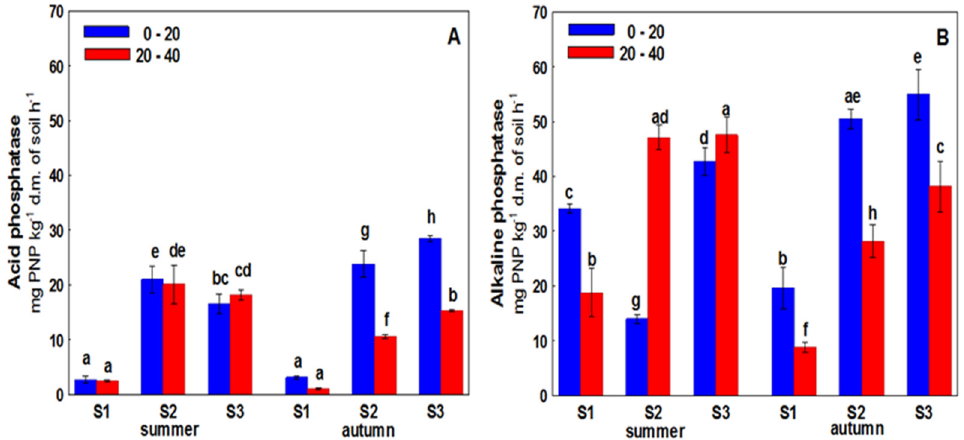
Figure 3. Enzymatic actvity in soil from 0–20 and 20–40 cm depths: ( A ) acid phosphatase; ( B ) alkaline phosphatase. Legend: S1, S2, S3—sampling sites located S1—5.88, S2—22.7 and S3—50.08 m from the reservoir with liquid post-production waste. Vertical lines indicate the standard deviation. Different letters above the columns indicate significant differences at p < 0.05.